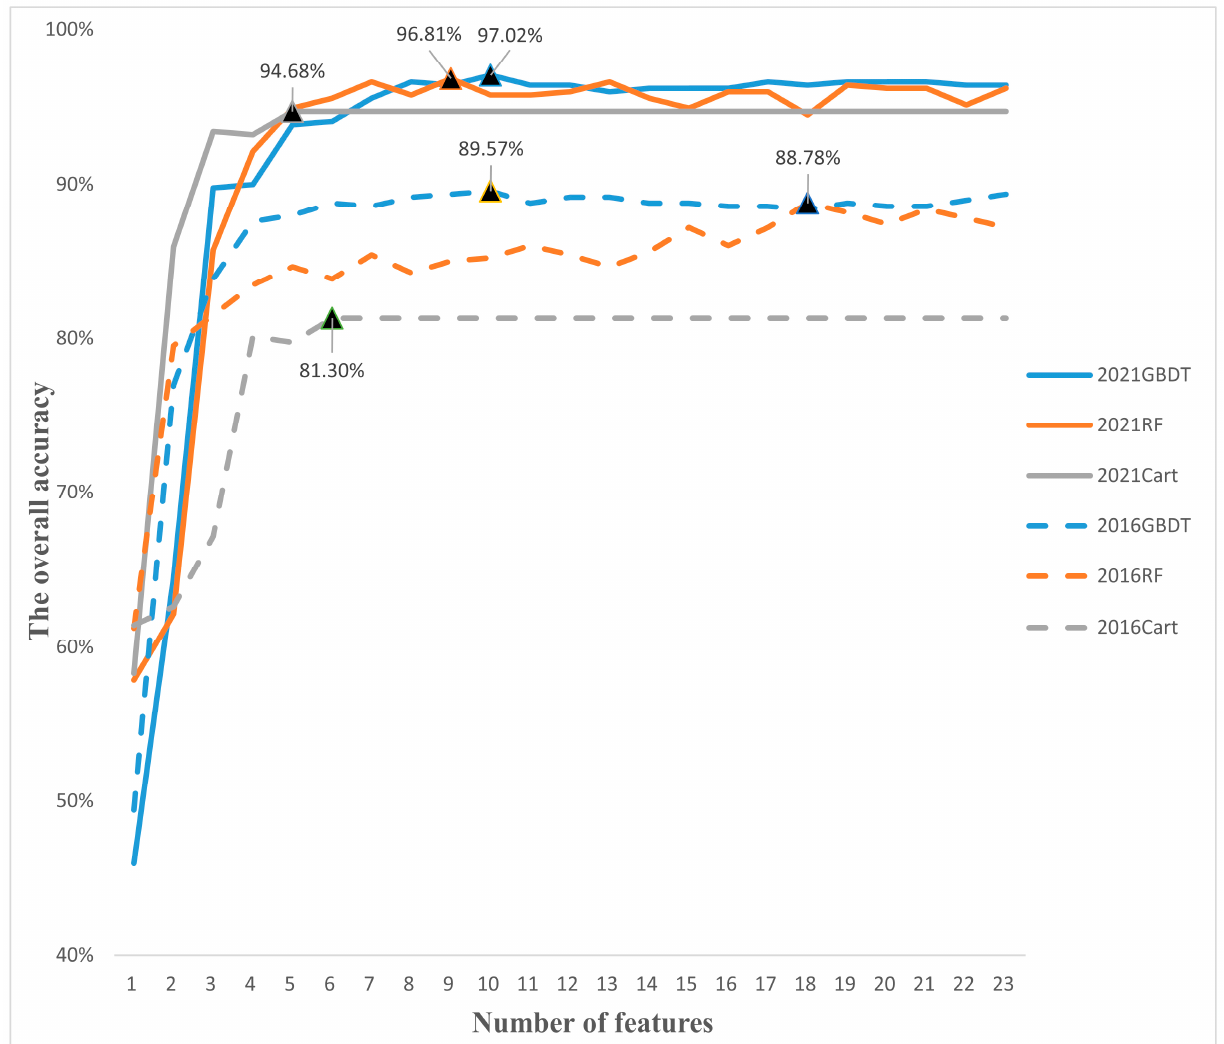
Figure 6. Classification feature analysis based on different classifications.